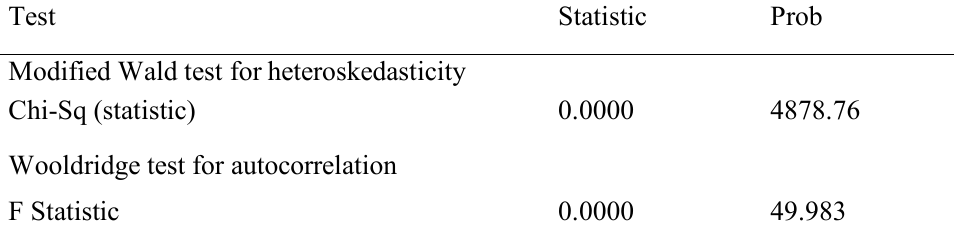
Table4 . The Modified Wald test and Wooldridge test